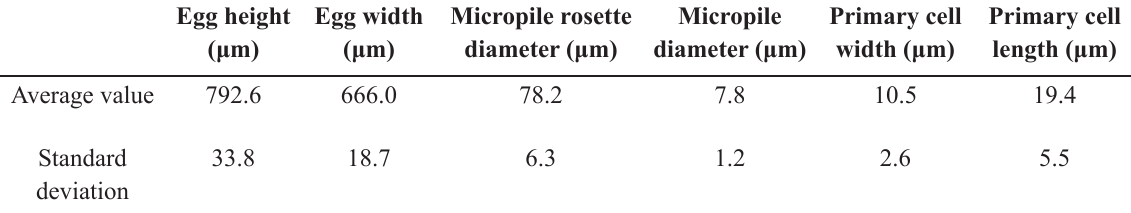
Table 3. Measurements of the egg of M. timandra binaludica subsp.